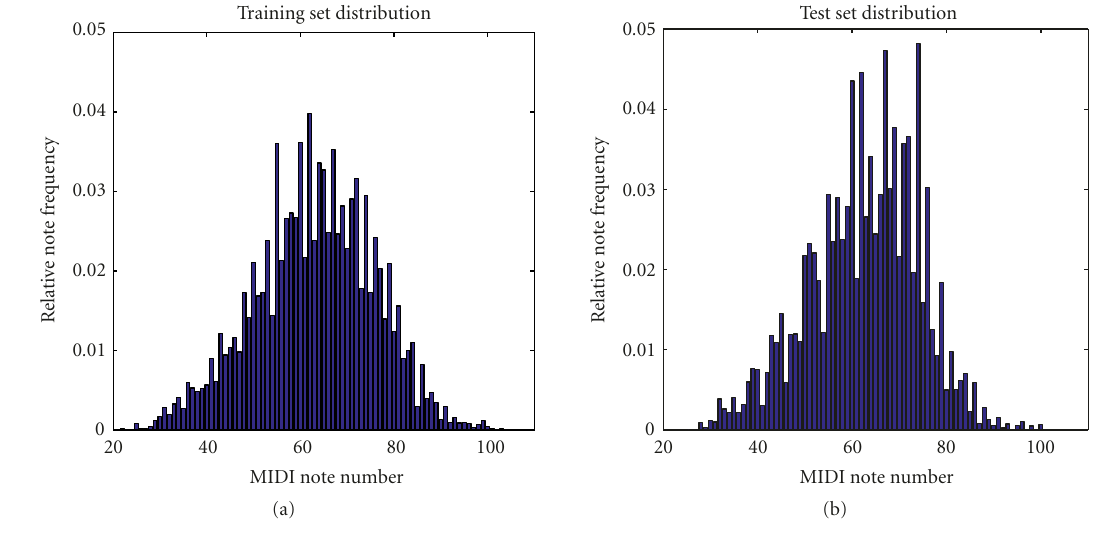
Figure 1: Note distributions for the training and test